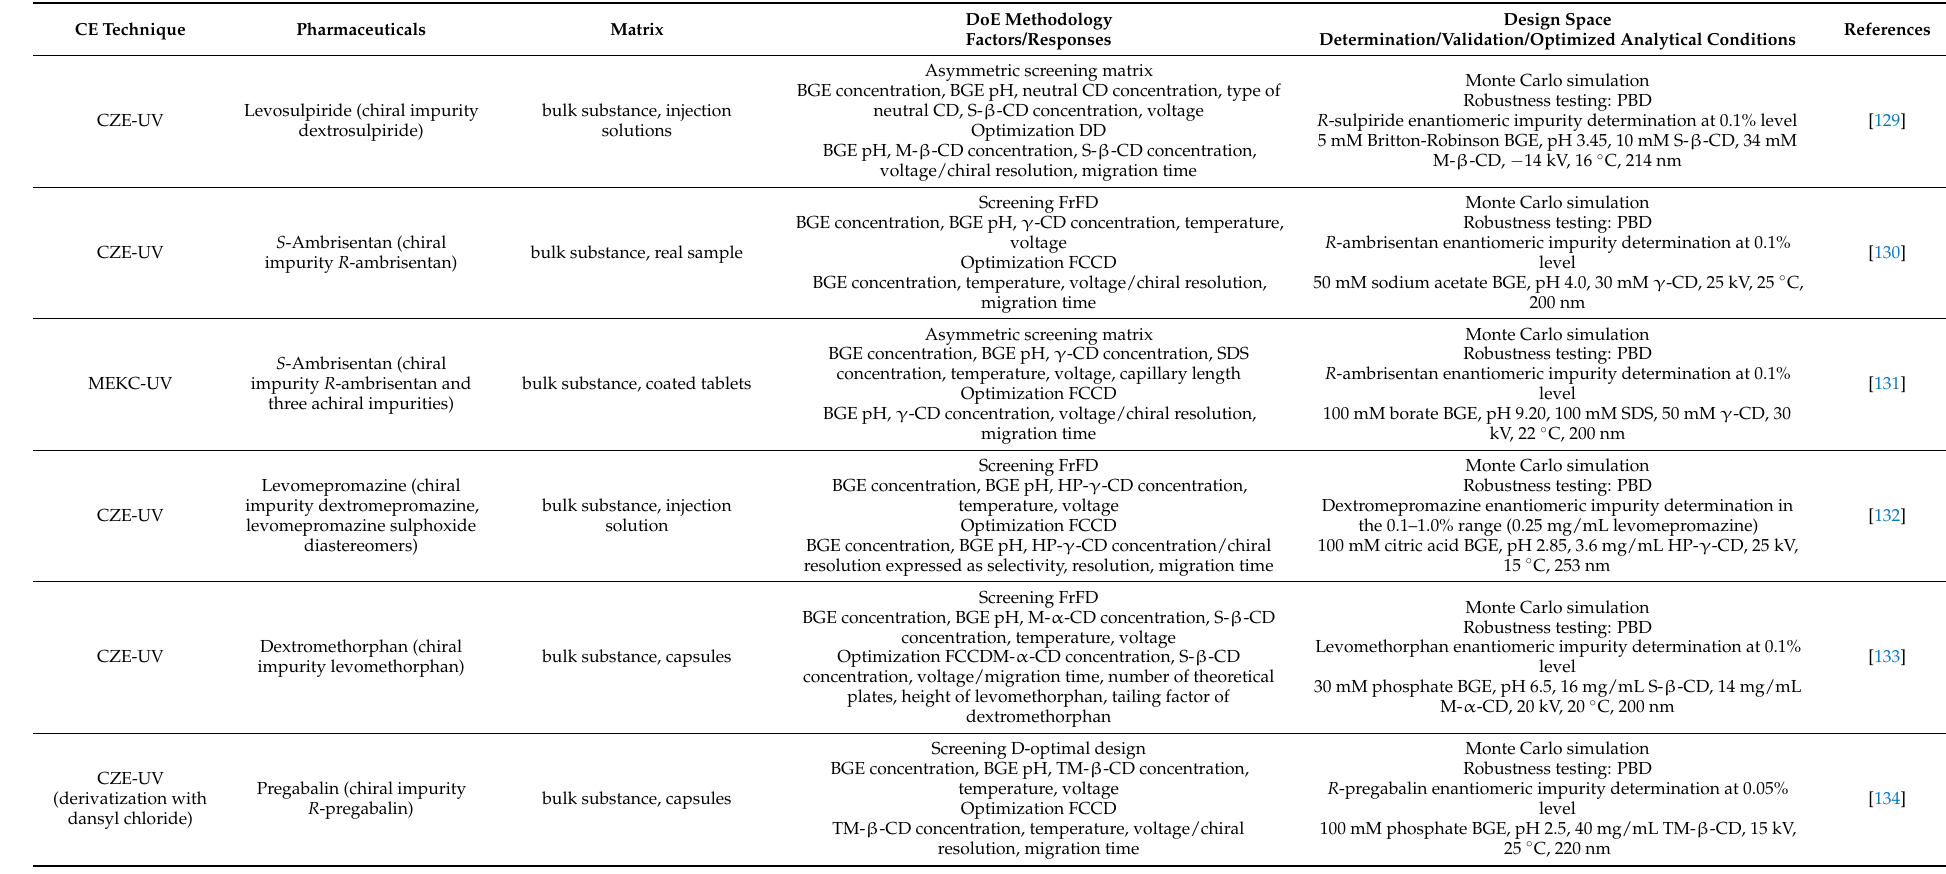
Table 2. Chiral CE methods for the chiral purity analysis of pharmaceuticals developed using AQbD approaches